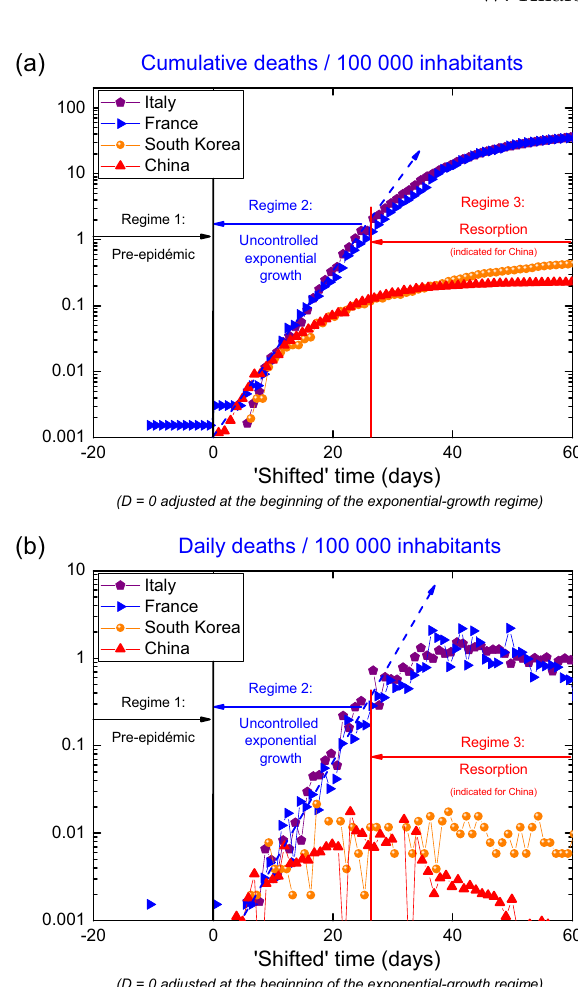
Figure 4. Identi fi cation of three regimes in a single-wave epidemic propagation, illustrated with their signatures in the variation of (a) cumulative deaths/100,000 inhabitants and (b) daily deaths/100,000 inhabitants of Italy, France, South Korea, and